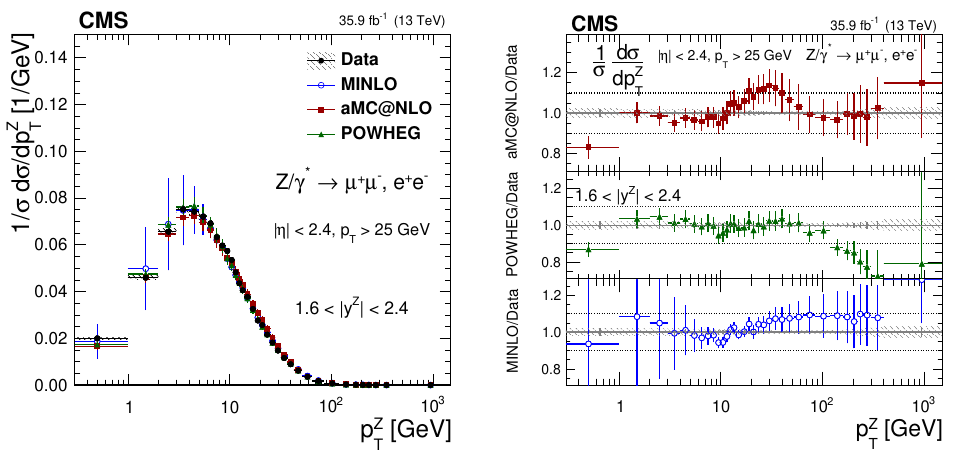
Figure 19 . The measured normalized cross sections (left) in bins of p Z region. The ratios of the predictions to the data are also shown (right). The shaded bands around the data points (black) correspond to the total experimental uncertainty. The measurement is compared to the predictions with MadGraph 5 a mc@nlo (square red markers), powheg (green triangles), and powheg - MINLO (blue circles). The error bands around the predictions correspond to the combined statistical, PDF, and scale